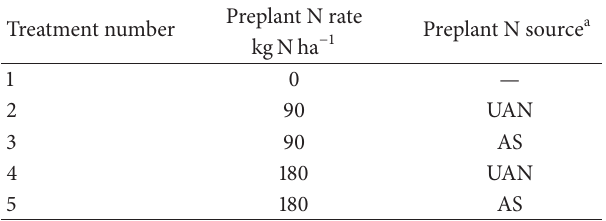
Table 2: Nitrogen fertilizer treatment structure applied to both irrigated and rain-fed plots in this